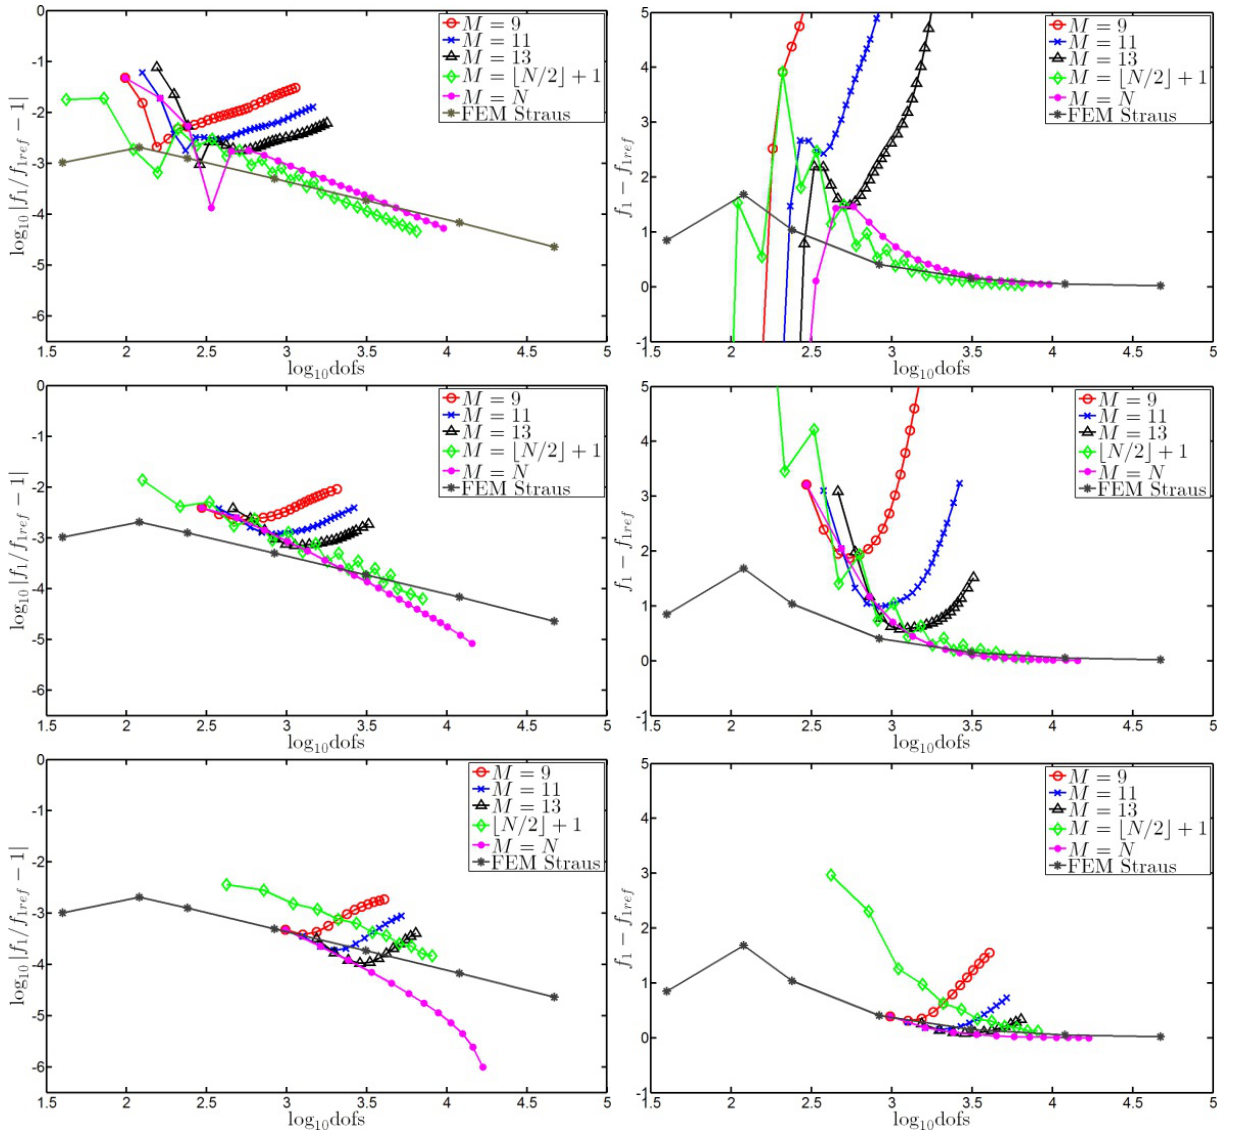
Figure 16: Convergence of the first natural frequency of a cantilever elastic beam with n e = 1 , n e = 3 , n e = 10 and different number of points along the two